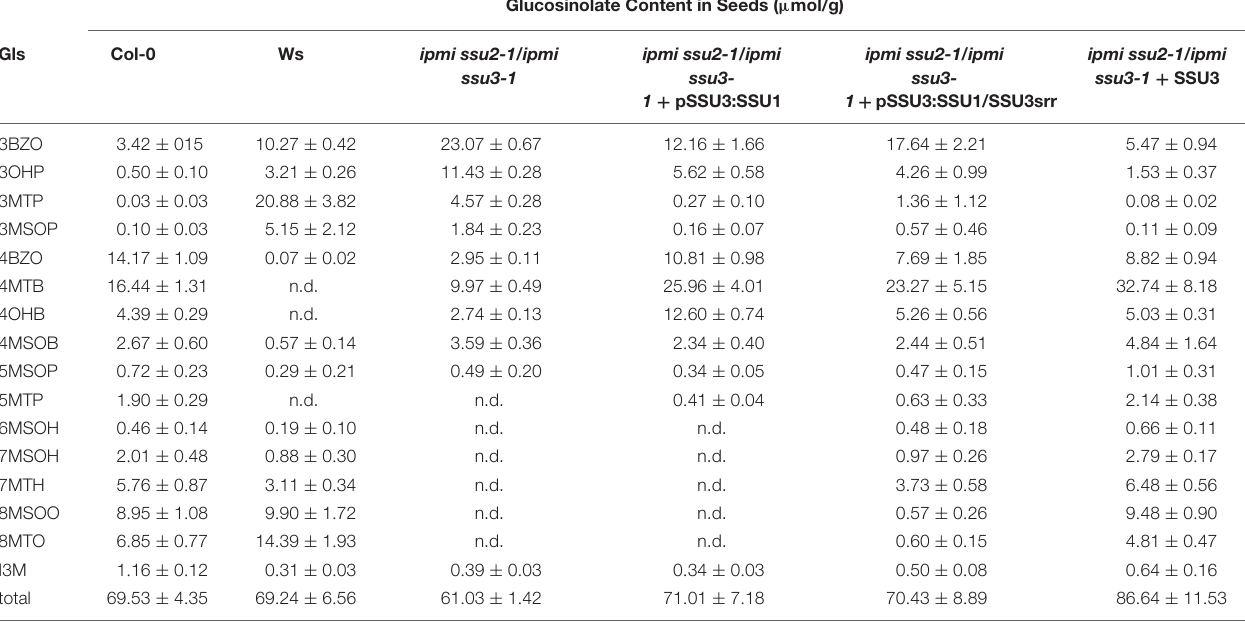
TABLE 1 | Glucosinolate content in seeds of different lines.